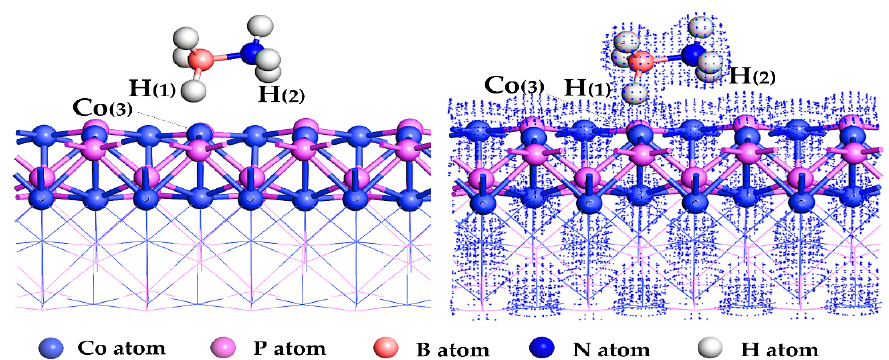
Figure 2. The left shows its adsorption configuration and the right shows the electron density diagram of the adsorption configuration of ammonia borane on the CoP(101) plane.